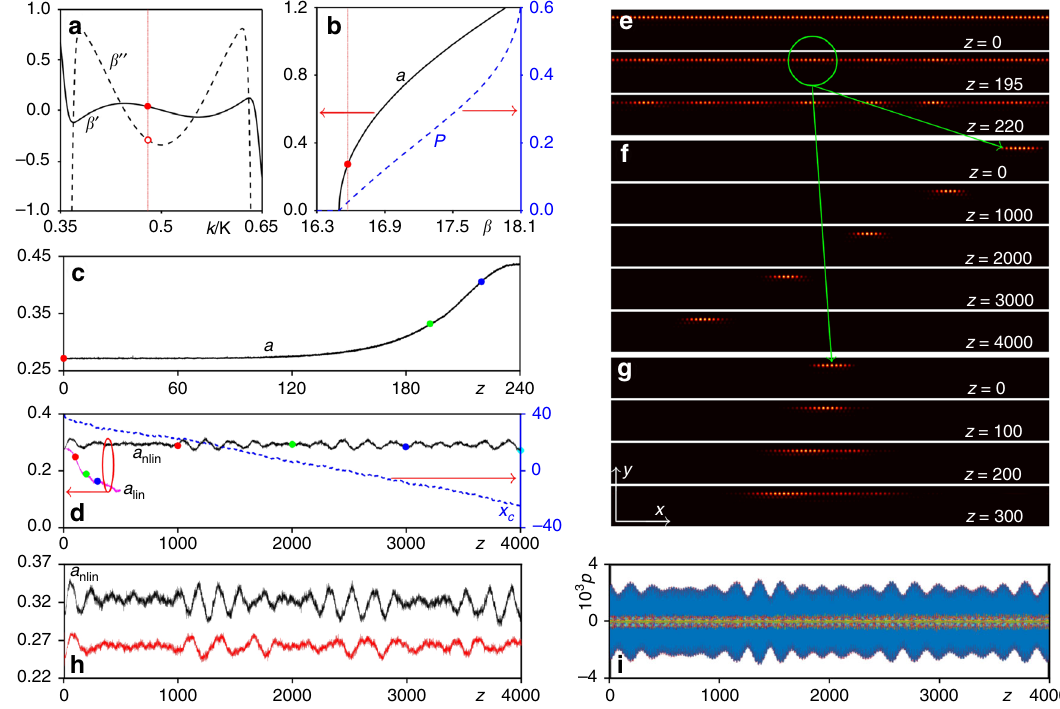
Fig. 3 Numerical simulations of edge quasi-solitons. a First β 0 and second-order β 00 derivatives for green branch of edge states from Fig. 1c. Vertical dotted line indicates the Bloch momentum k ¼ 0 : 48 K . b Nonlinear edge state family at k ¼ 0 : 48 K . Solid and dashed curves show peak amplitude a and norm P versus β . c Peak amplitude of the nonlinear edge state with β ¼ 16 : 573 (corresponding to the red dot in ( b )) versus distance illustrating the development of modulation instability. d Amplitude a and center position x c of quasi-soliton from panel f versus propagation distance. The amplitude a for the same input in linear nlin lin medium is shown too. e Nonlinear edge state intensity distributions at different propagating distances corresponding to the dots in ( c ). f Quasi-soliton intensity distributions at different propagation distances corresponding to the dots in a curve in ( e ). g Diffraction in linear medium, distributions shown correspond to nlin the dots in a curve in ( d ). h Evolution of the peak amplitude a of the quasi-soliton in the case when input amplitude was increased (top curve) and lin nlin decreased (bottom curve) by 10 % . i Projection p of the soliton fi eld distribution at different distances on bulk Bloch modes of the